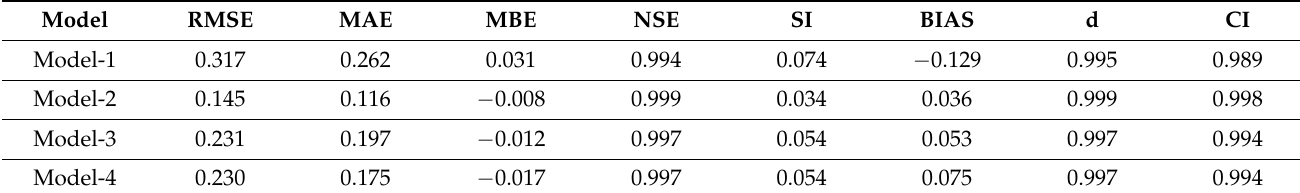
Table 7. Statistical indicators values using PNN method during testing period.